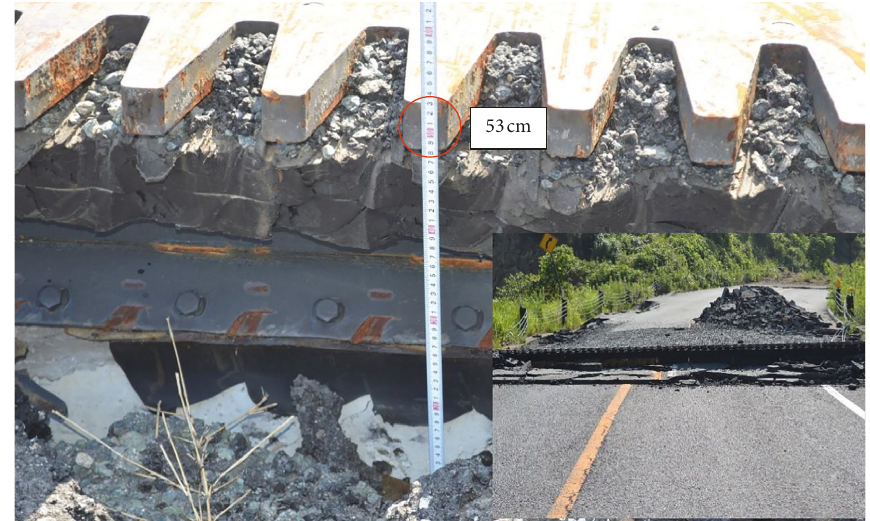
Figure 12: Damage to abutment A2